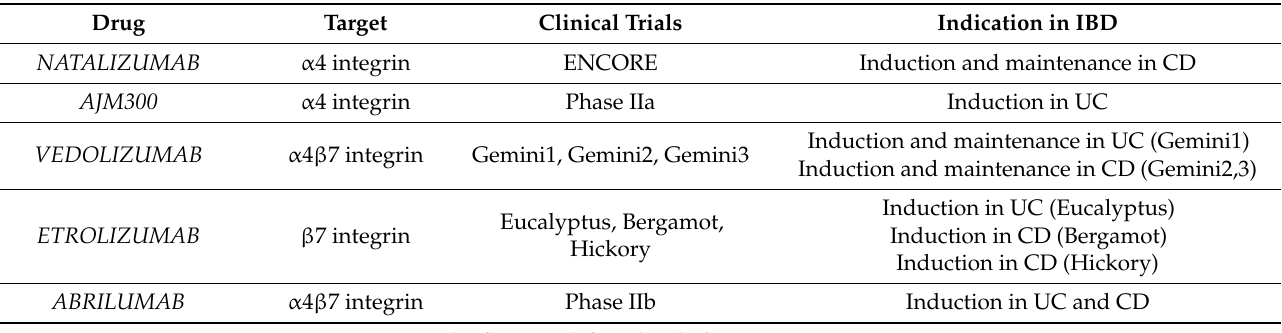
Table 1. Anti-integrin therapies in